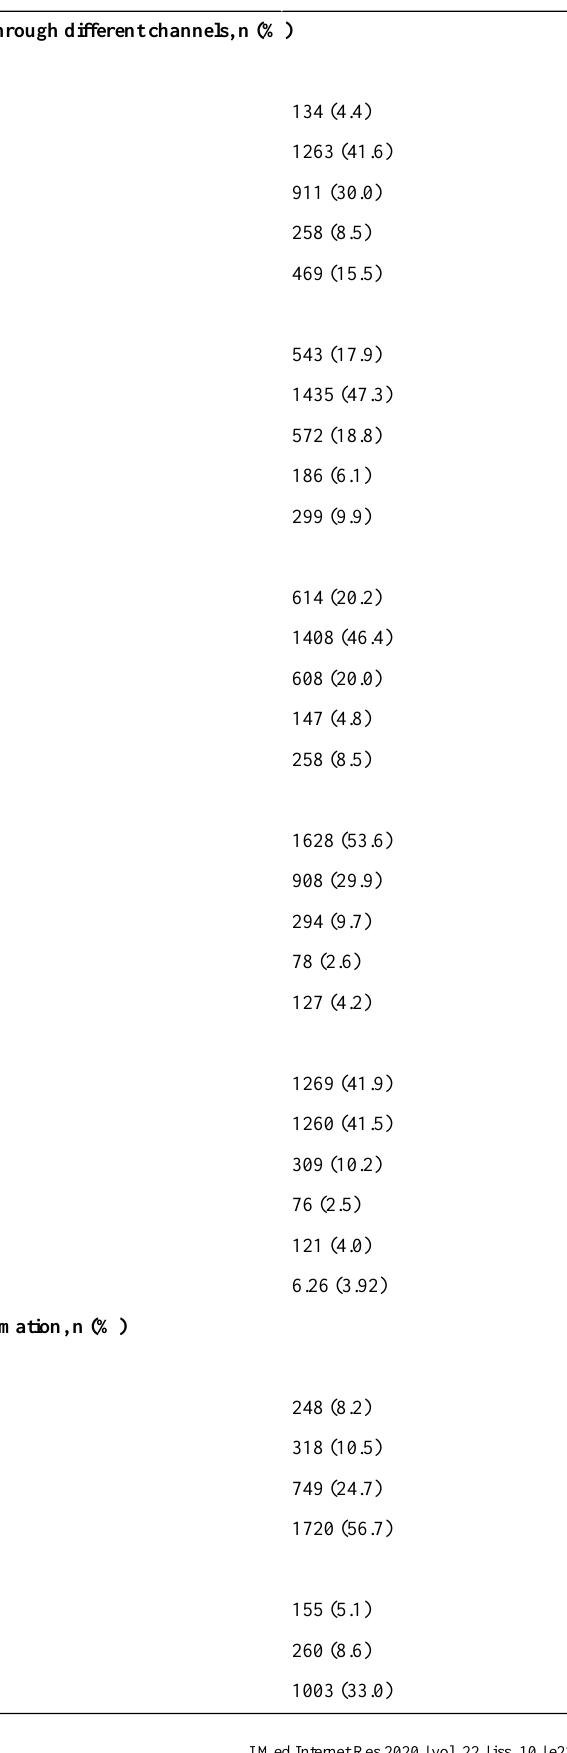
Table 2. Exposure to COVID-19–specific information in the study sample (N=3035).